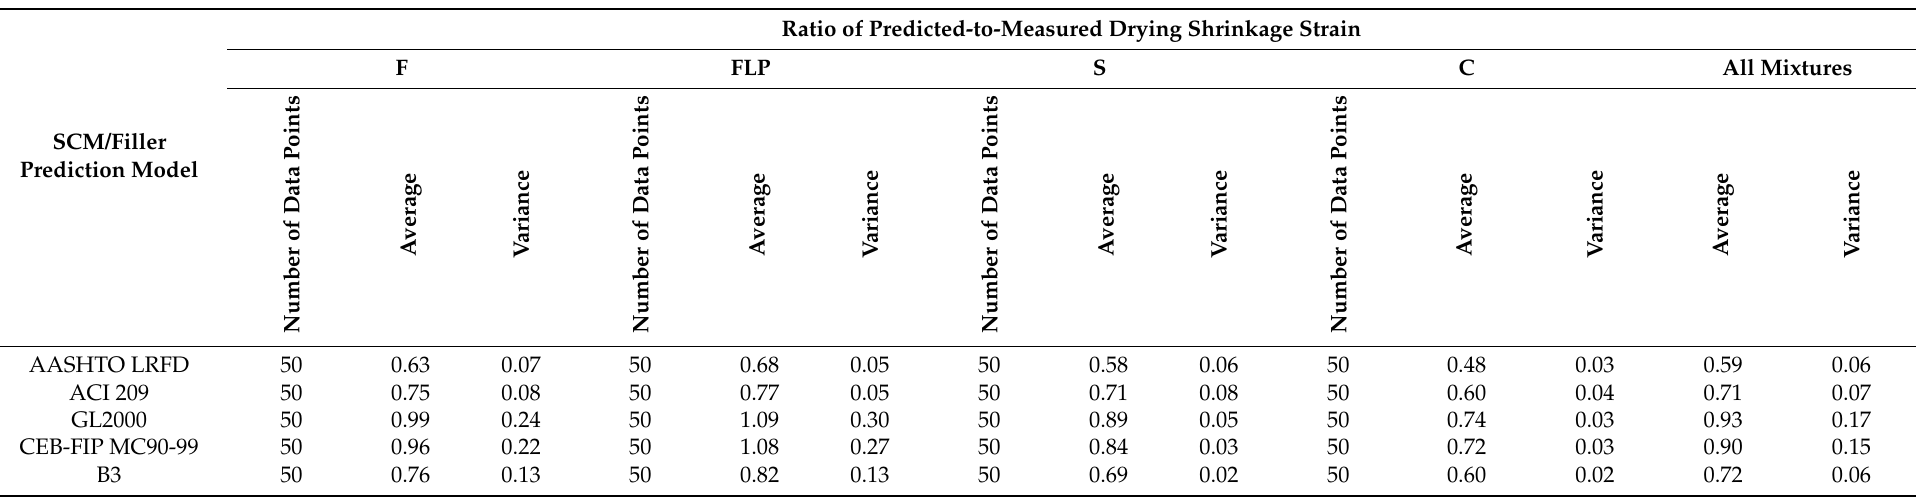
Table 11. Statistical analysis results of drying shrinkage predictions for SCC containing different types of